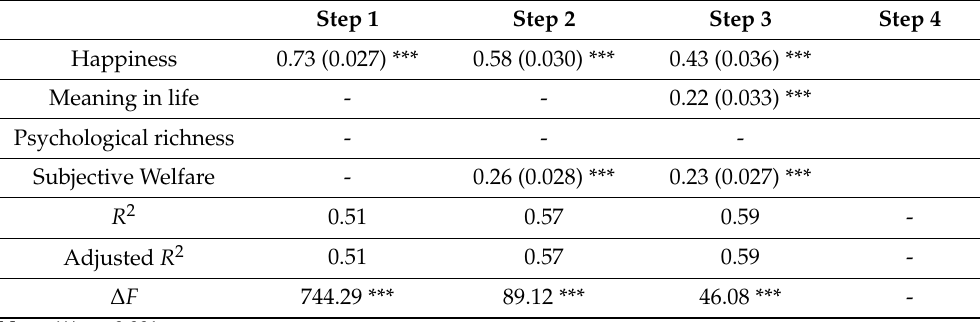
Table 4. Stepwise regression of a good life on the three wellbeing dimensions and subjective welfare. Step 1 Step 2 Step 3 Step 4 Happiness 0.73 (0.027) *** 0.58 (0.030) *** 0.43 (0.036) *** Meaning in life - - 0.22 (0.033) *** Psychological richness - - - Subjective Welfare - 0.26 (0.028) *** 0.23 (0.027) *** R 2 0.51 0.57 0.59 - Adjusted R 2 0.51 0.57 0.59 - ∆ F 744.29 *** 89.12 *** 46.08 ***